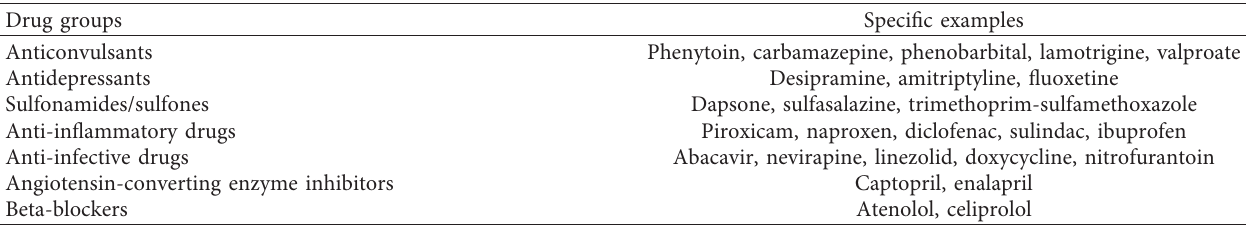
Table 1: Drug groups commonly associated with drug reaction with eosinophilia and systemic symptoms syndrome. Drug groups Specific